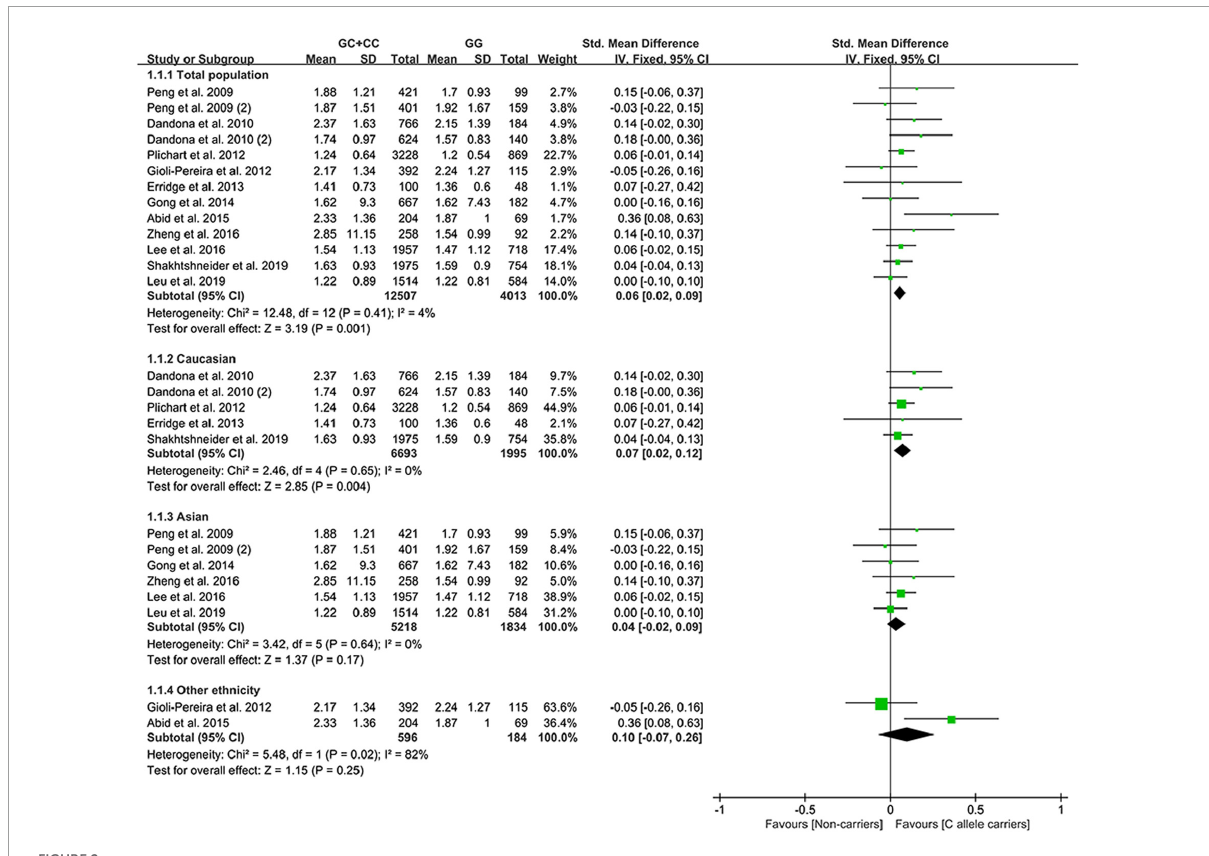
FIGURE2 A forest plot of lncRNA rs1333049 variant with circulating TG